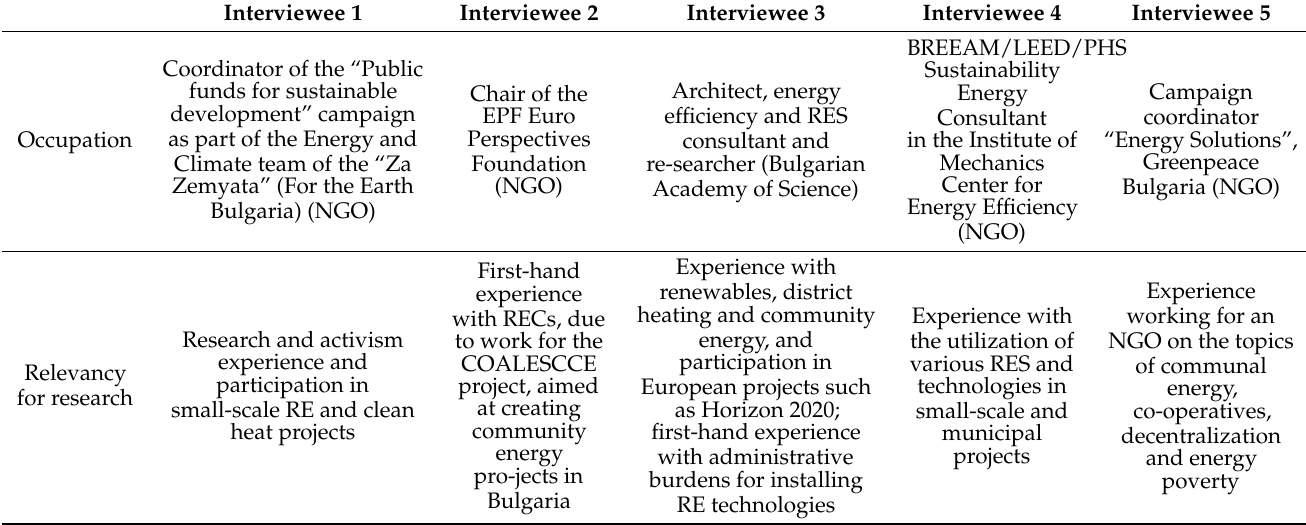
Table 1. An overview of the expert interviews, conducted as part of the country analysis of